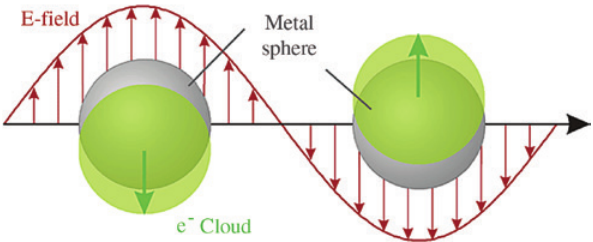
Figure 1: Schematic of plasmon oscillation for a sphere, showing the displacement of the conduction electron charge cloud relative to the nuclei. Reprinted with permission from [24]. Copyright 2003 American Chemical